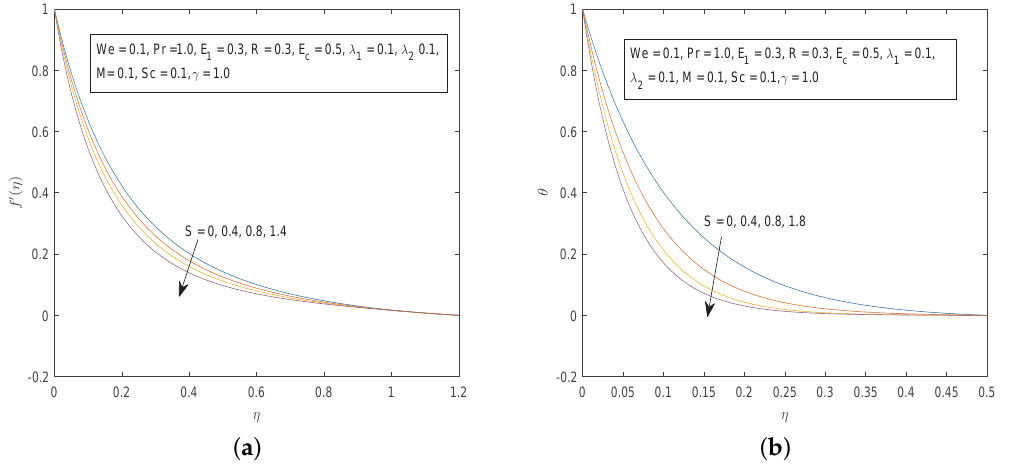
Figure 10. ( a ) Effects of S on f (cid:48) ( η ) and ( b ) Effects of S on θ